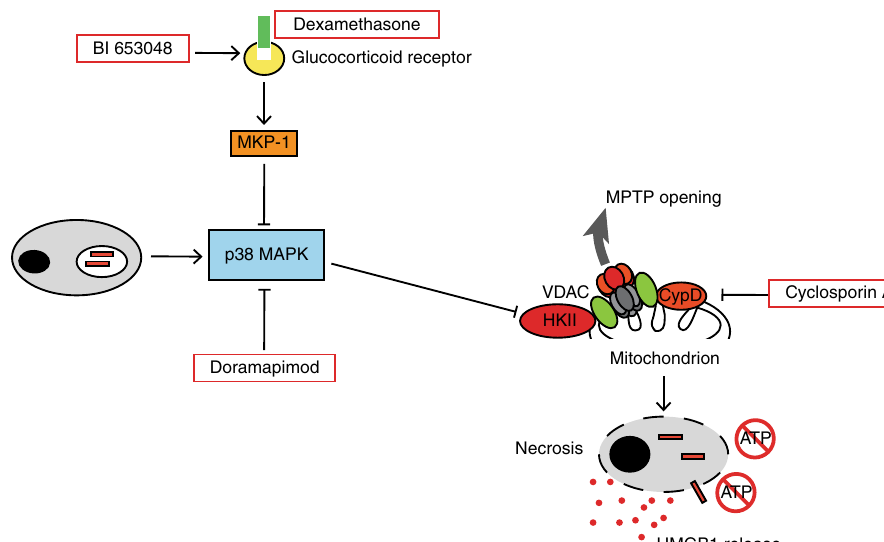
Fig. 9 Model depicting a novel mode of Mtb- induced cell death and its chemical inhibition. Phagocytosis of Mtb leads to p38 MAPK phosphorylation and hexokinase II (HKII) dissociation, which seems to open the mitochondrial permeability transition pore (mPTP) subsequently leading to necrotic cell death which can be monitored by high-mobility group protein B1 (HMGB1) release. Several substances interfere with this pathway to protect cells. Dexamethasone or BI653048 treatment inhibits p38 MAPK phosphorylation via the glucocorticoid receptor (GR) and MAPK phosphatase 1 (MKP-1). Direct p38 MAPK blockade using doramapimod has a similar cytoprotective effect. p38 MAPK promotes dissociation of hexokinase II (HKII) from